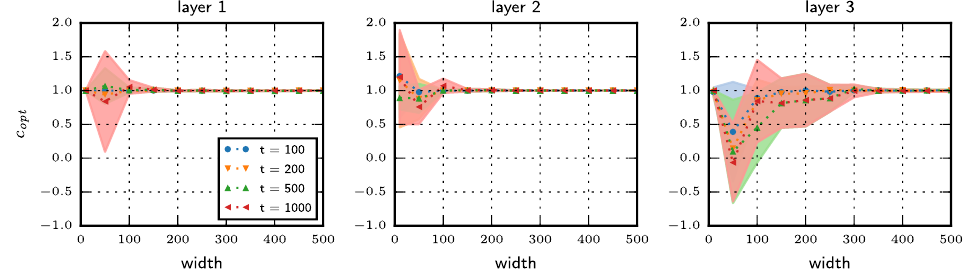
Figure A1. Fitting of the line across the maxima of the distribution of final weights in the networks of Figure 4. The parameter c opt is the slope obtained by fitting a straight line to the peaks of the distri- butions of trained weights w f for fixed w i . These results are averages measured in ten independent realizations, and the shaded areas represents the dispersion (standard deviation across